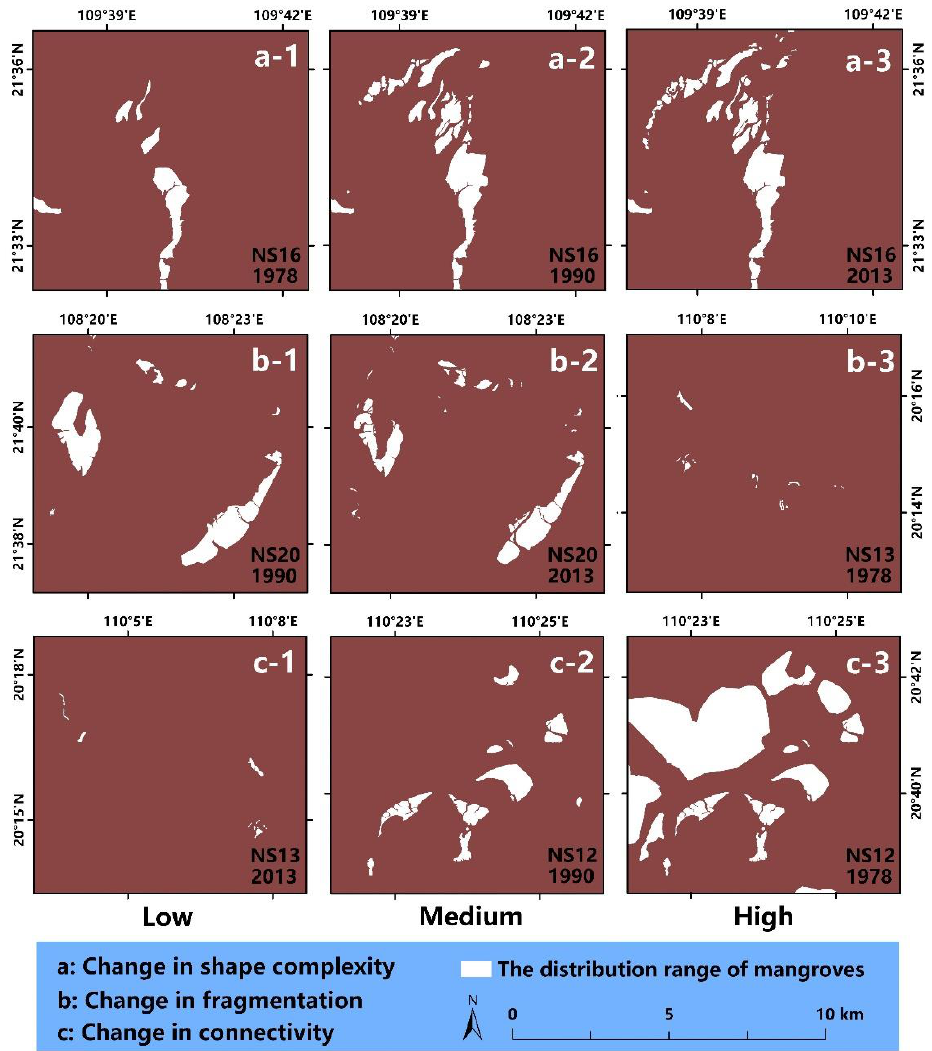
Figure 9. Mangrove patch changes for different levels of ( a ) shape complexity, ( b ) fragmentation and ( c ) connectivity. The above analysis of the temporal and spatial changes in the different landscape characteristics shows that the same natural shore has different performances for the dif- ferent landscape characteristics. For example, the poor connectivity of a certain shore does not mean that it has the same performance for the other landscape characteristics. There- fore, it is not sufficient or accurate to analyze one of the characteristics when comparing the landscape patterns of different shores. It is necessary to establish an integrated land- scape index that can reflect the comprehensive state of the landscape. Taking the Zhan- jiang–Anpu shore (NS15) as an example, the changes in the four landscape characteristics are as follows (Figure 10). The total area maintained a significant growth level over the last 40 years. The shape complexity was intermediate before 2000, and then, it became high, implying that the impact of artificial interferences decreased. The fragmentation re- mained at a low level, and the connectivity remained at a medium level over the last 40 years. There are obvious differences between the four different landscape characteristics. After calculating the ILI, it was found that the level of the integrated landscape state level was medium before 2000, and then, it changed to high. Over the last 40 years, the inte- grated landscape state has gradually improved. According to some studies on mangrove in Zhanjiang [24,56,57], the largest mangrove protection area exists in the coastal area of mainland China, namely Zhanjiang mangrove protection area, distributed in NS15. The